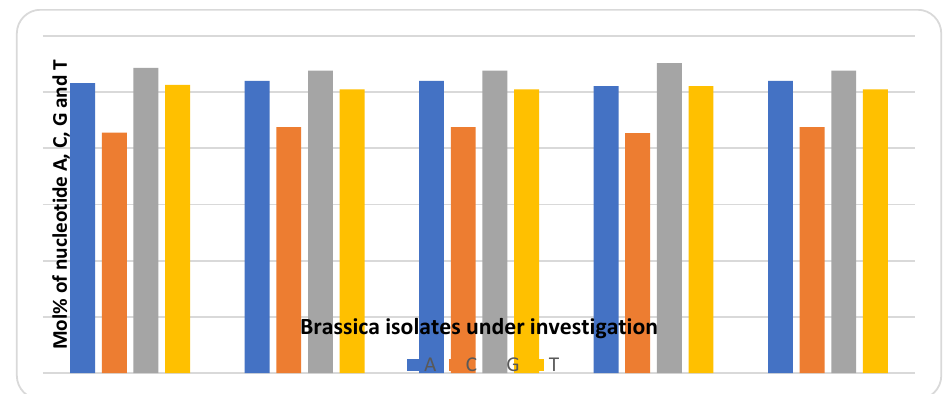
Figure 4. Molecular weight % of nucleotide, Adenin (A), Cytosin (C), Guanin (G) and Thymin (T) in ITS sequences of the Brassica accessions under investigation.